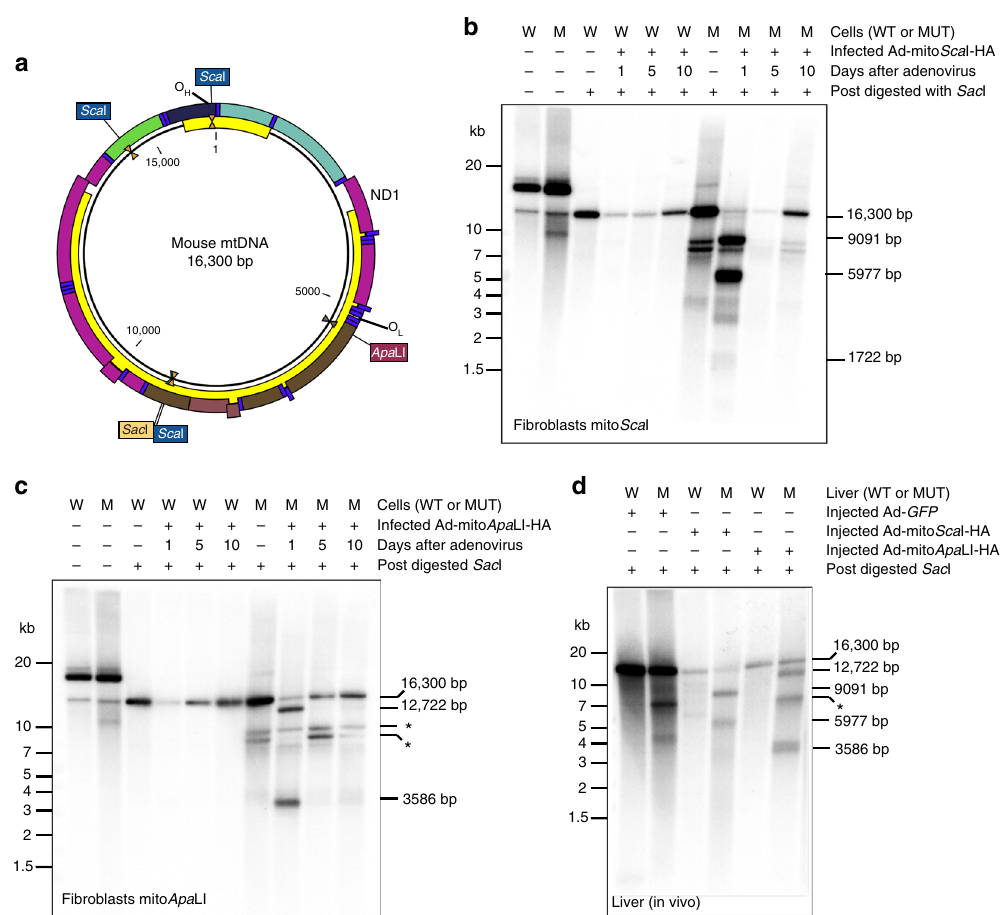
Fig. 2 Delayed degradation of mtDNA after DSB in DNA from fi broblasts and the liver of the mutator mouse. a Diagram of wild-type C57BL6/J mtDNA illustrating the location and number of restriction endonuclease sites. Southern blot from mutator and wild-type fi broblasts infected with ( b ) Ad-mito Sca I- HA and ( c) Ad-mito Apa LI-HA at 1, 5, and 10 days post-infection. d Southern blot from mutator and wild-type mice liver 5 days after retro-orbital injections with Ad- GFP , Ad-mito Sca I-HA, or Ad-mito Apa LI-HA. DNA was post-digested with Sac I to linearize mtDNA. Zeta-Probe membrane was hybridized with a [ α - 32 P] dCTP labeled probe covering 11.7 kb of